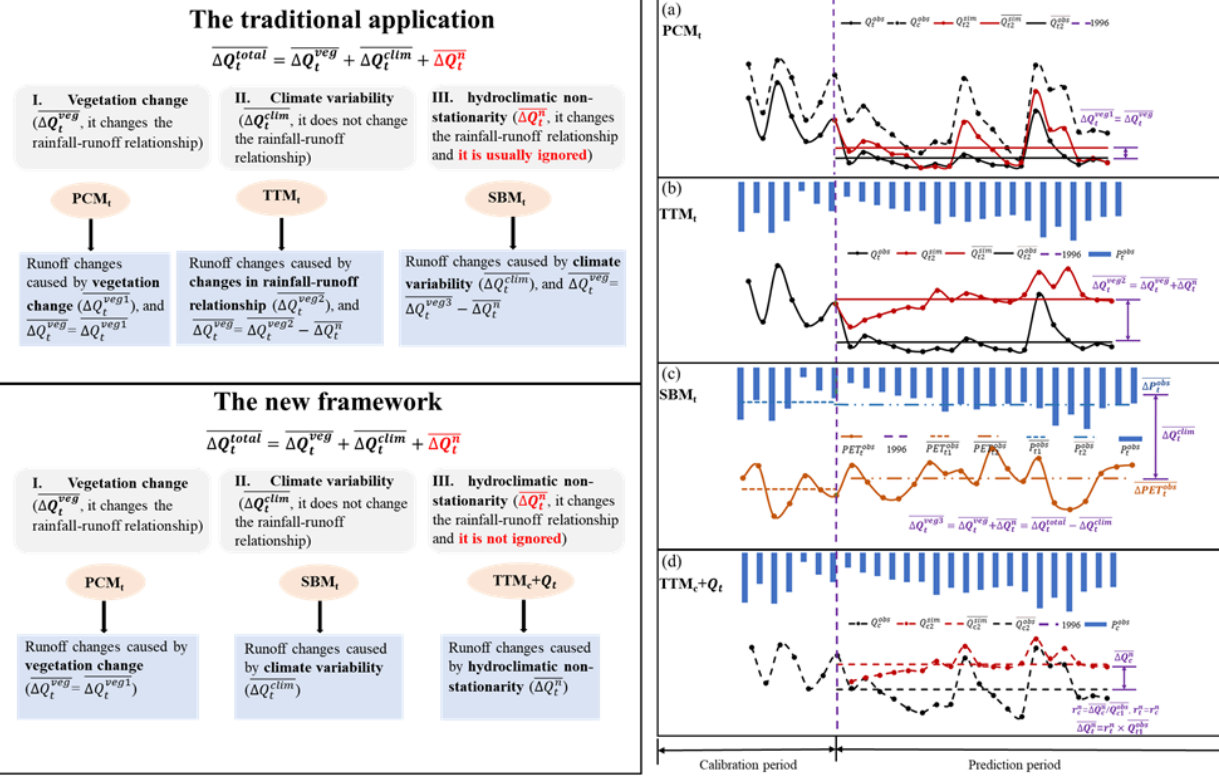
Figure 3. Schematic diagram showing principles of the traditional application and the new framework. PCM means paired-catchment method, TTM means time–trend method, SBM means sensitivity-based method and subscripts “c” and “t” represent the control catchment and the treated catchment. (a) The PCM for estimating runoff change caused by vegetation change, (b) the TTM for estimating runoff change caused by vegetation change and hydroclimatic non-stationarity, (c) the SBM for estimating runoff change caused by climate variability, and (d) the TTM used in the control catchment and runoff of the treated catchment for estimating runoff change caused by hydroclimatic